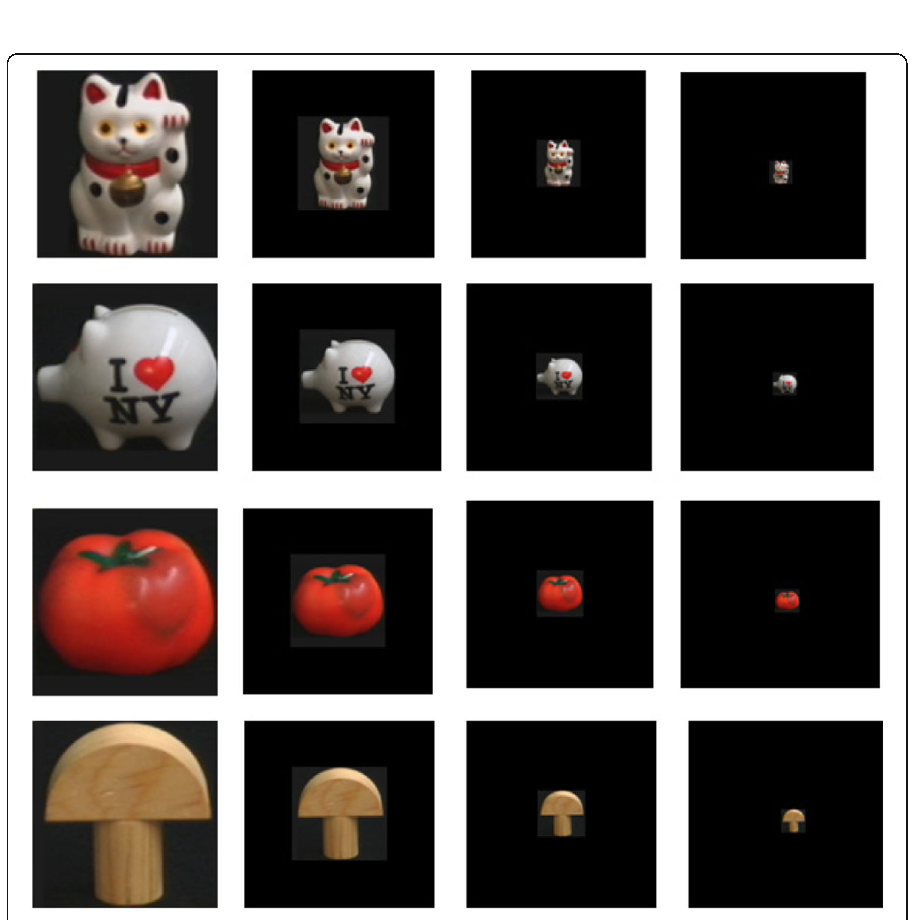
Fig. 8 Some classic color sample images selected from the COIL-100 database and scaled to different sizes (left to right: 256 × 256, 128 × 128, 64 × 64, and 32 ×